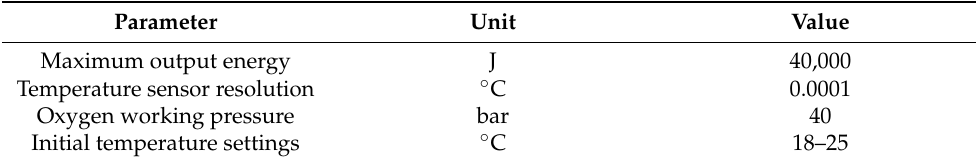
Table 3. Technical specifications of the IKA C 200 calorimeter.